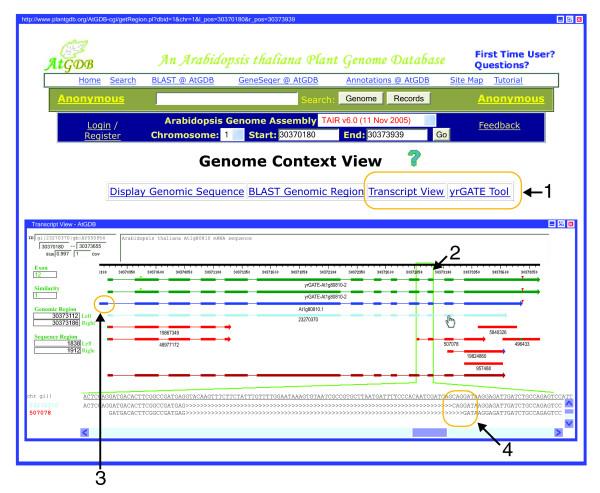
Community implementation of yrGATE at the PlantGDB Arabidopsis genome browser, AtGDB, for correction of a public annotation and for alternative splicing. This two-window screenshot depicts yrGATE annotations in the AtGDB browser. The outer window contains a genome context view of AtGDB, which has links to the yrGATE Annotation Tool and to AtGDB's Transcript View (1). The inner window contains the Transcript View, which presents a genome context graphic and sequence alignments represented in the graphic. The graphic has the following color assignments: yrGATE annotations, green; the public annotation, blue; cDNAs, light blue; ESTs, red; annotation protein coding regions, green and red triangles. The multiple sequence alignment in the lower panel of the Transcript View corresponds to the region of graphic contained within the green rectangle (2). The first exon (3) of the public annotation, At1g80810.1, is not supported by expressed sequence evidence, which instead suggests a downstream exon. There are two yrGATE community annotations, yrGATE-At1g80810-1 and yrGATE-At1g80810-2, both of which contain the first exon supported by the evidence but differ at the 3'-end, because the evidence suggests two alternatives for exon 11 (as seen in the multiple alignment display (4)).